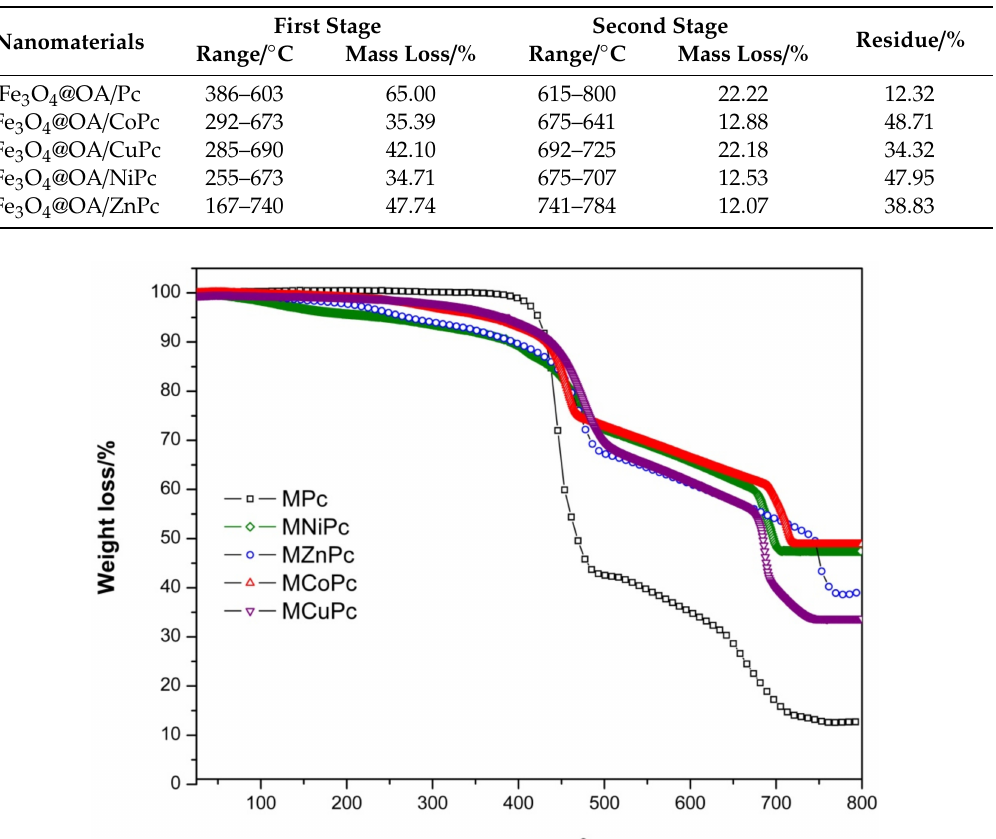
Table 1. Degradation temperatures, mass losses and mass residues of pyrolysis decomposition at heating rates of 10 ◦ C min − 1.